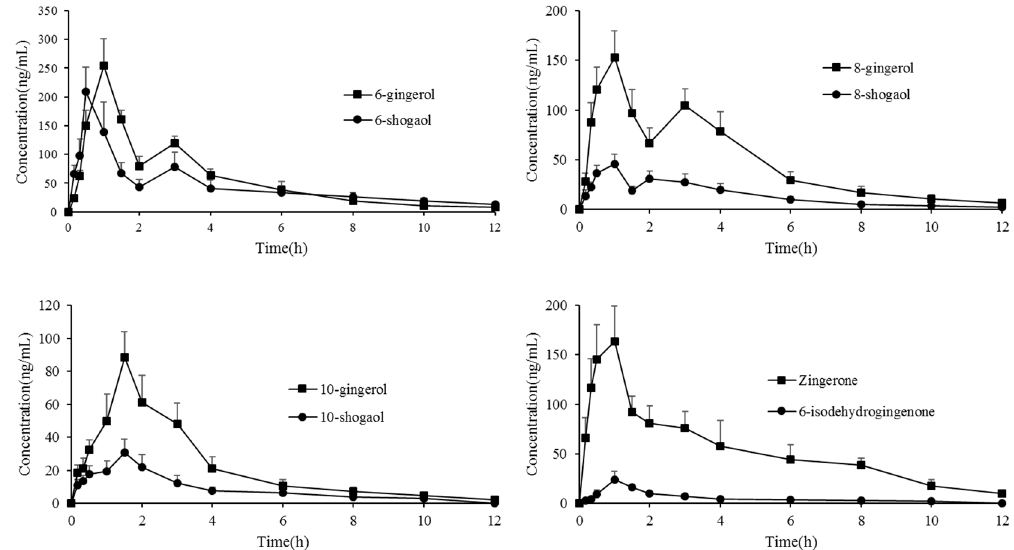
Figure 3. Mean plasma concentration–time curves of eight analytes after oral administration of ginger extract at a dose of 400 mg/kg. ( n = 10, mean ± SD). Table 1. Pharmacokinetic parameters of eight constituents in rats plasma after oral administration of ginger extract at a dose of 400 mg/kg ( n = 10, mean ± SD).